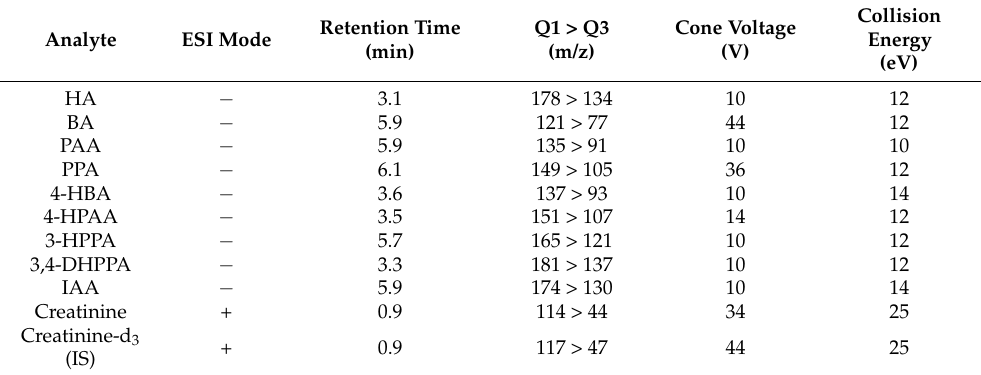
Table 3. MRM conditions for nine organic acids and